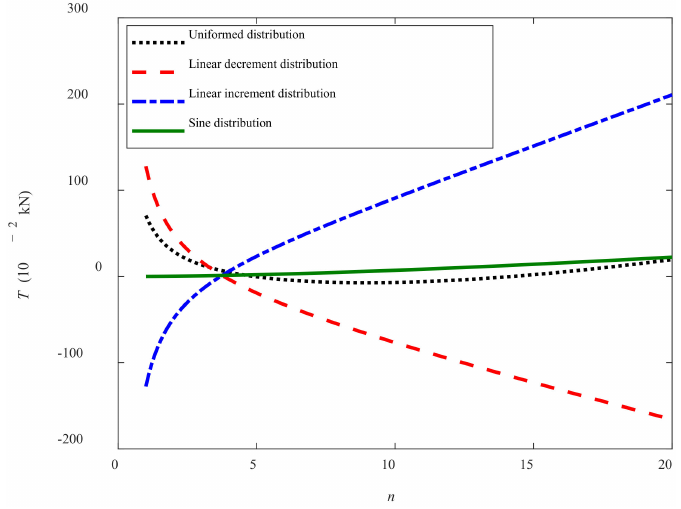
Figure 13. Curves of traction force vs. time.